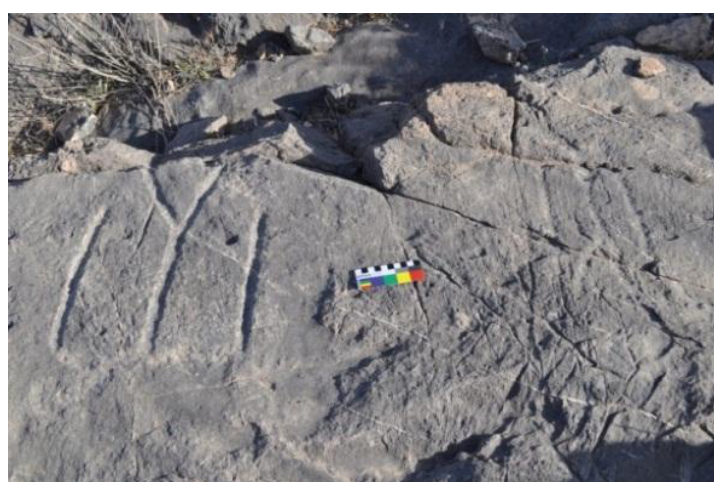
Figure 6. Ghārā-Tepe I, panel 4, geometric